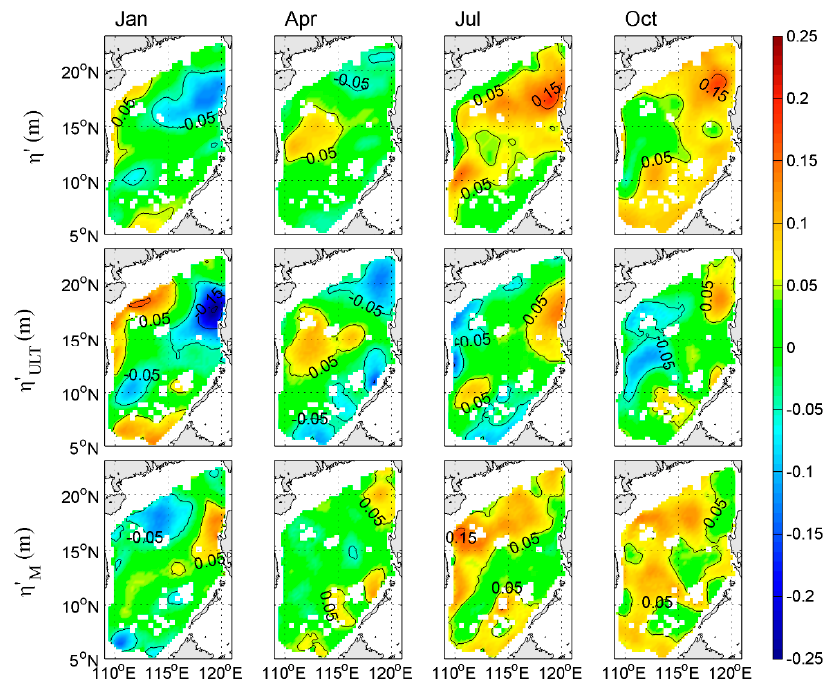
 , ULT  and M  (CI: 0.1 m). and η (cid:48) (CI: 0.1 m). ULT M